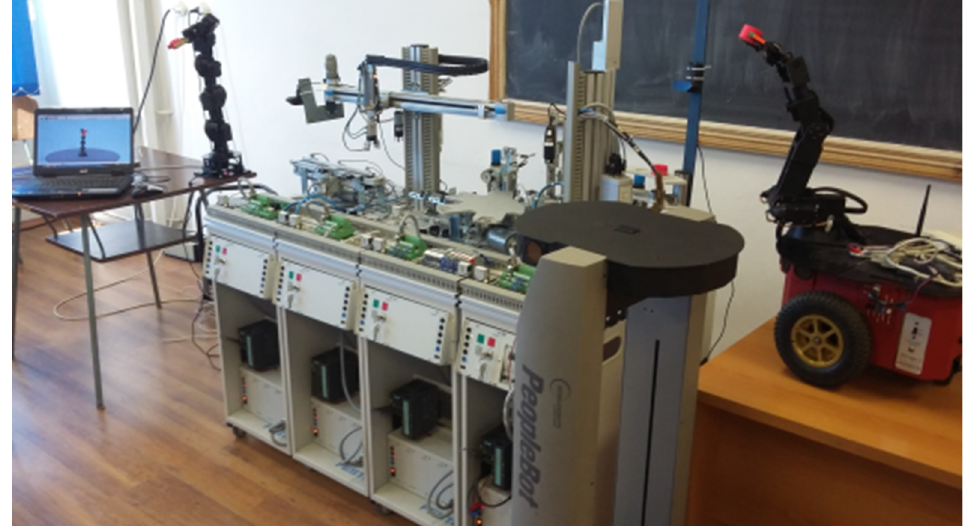
Figure 1. Processing / reprocessing mechatronics line (P / RML) assisted by autonomous robotic systems (ARSs), robotic manipulators (RMs) and visual servoing systems (VSSs).